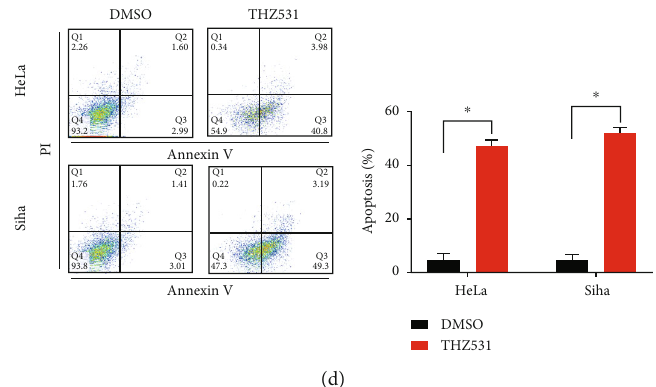
Figure 3: CDK12 regulates the cell cycle and protects from apoptosis in CC cells. (a) Cell cycle analysis of CDK12 knockdown versus control in HeLa and Siha cells. (b) Apoptosis analysis of CDK12 knockdown versus control in HeLa and Siha cells. (c) Cell cycle analysis of 200nM THZ531 vs. DMSO in HeLa and Siha cells. (d) Apoptosis analysis of 200nM THZ531 vs. DMSO in HeLa and Siha cells. Two-tailed t -test, ∗ P < 0 : 05 . FITC: fl uorescein isothiocyanate; PI: propidium